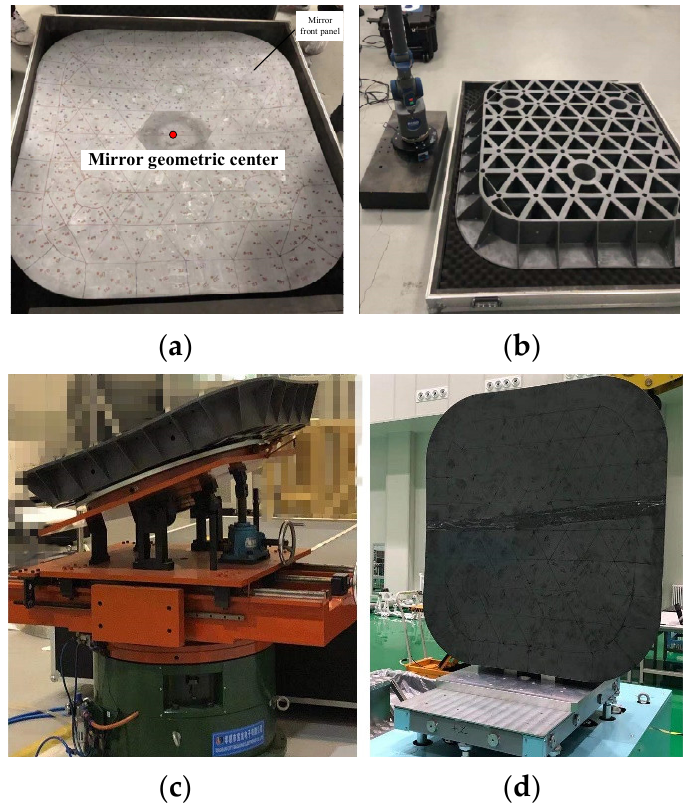
Figure 10. The state of mirror parameters and center of gravity measurement. ( a ) Measure the thickness of the front panel and the mirror center. ( b ) Measure the mirror lightweight rib and back plate parameters. ( c ) Measure the center of gravity of the mirror by tilting 30 degrees. ( d ) Measure the center of gravity of the mirror by vertical 90 degrees.